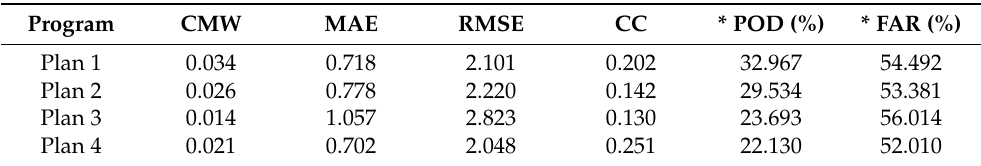
Table 6. The different verification scores of hourly precipitation forecast in the next six hours